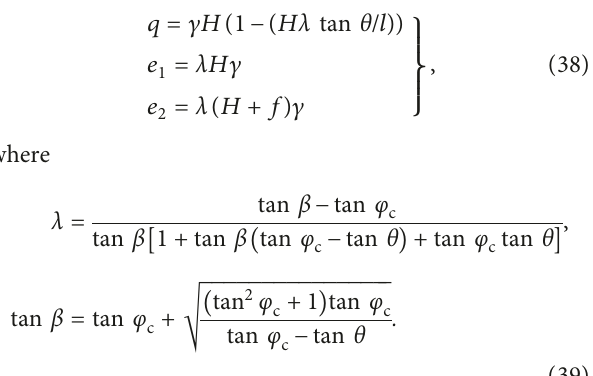
Table 1: Physical and mechanics parameters of the soil. Items